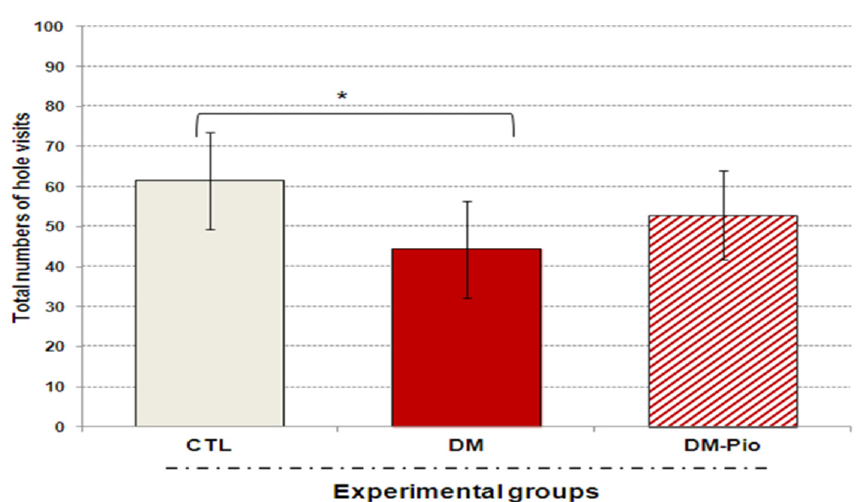
Figure 2. Effect of pioglitazone on exploratory activity of mice with neuroinflammation linked to diabetes. The bar height represents the mean ± SD for individual experimental groups: CTL: non-diabetic mice, DM: diabetic mice, DM-Pio: pioglitazone-treated mice [30 mg/kg, po ]. One-way ANOVA, followed by Tukey’s post hoc test was used. * p < 0.05 in comparison with control group.